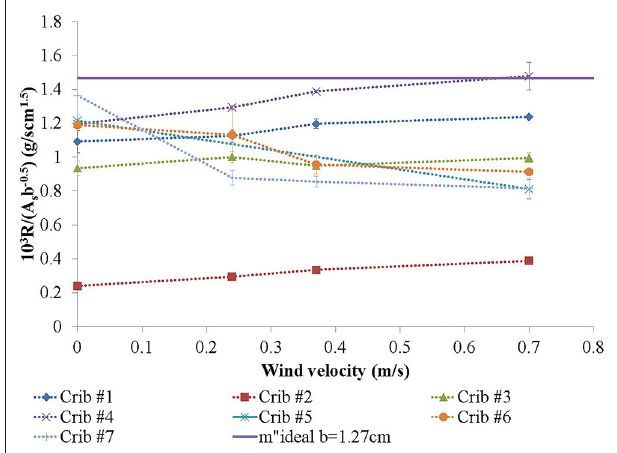
Table 1 for details on fuel bed